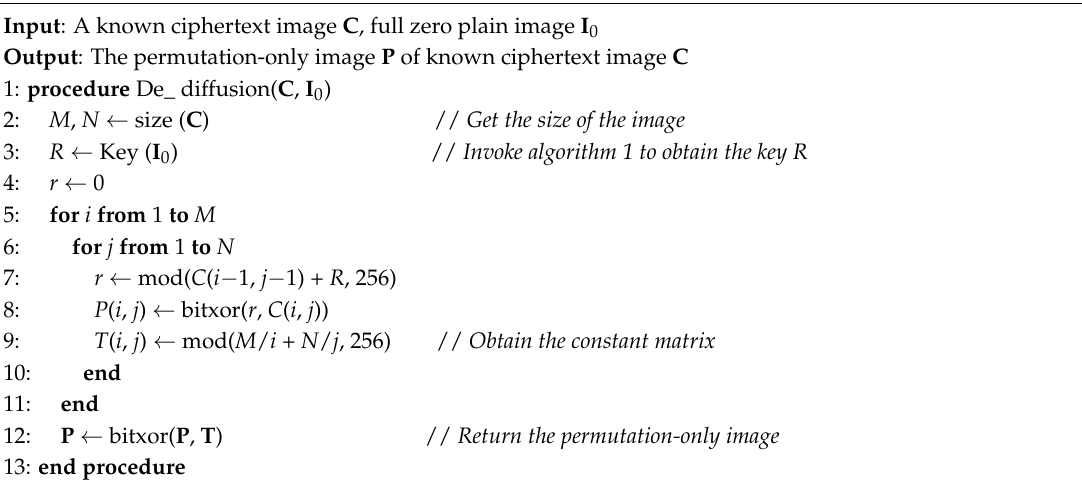
Algorithm 3 Proposed diffusion attack algorithm